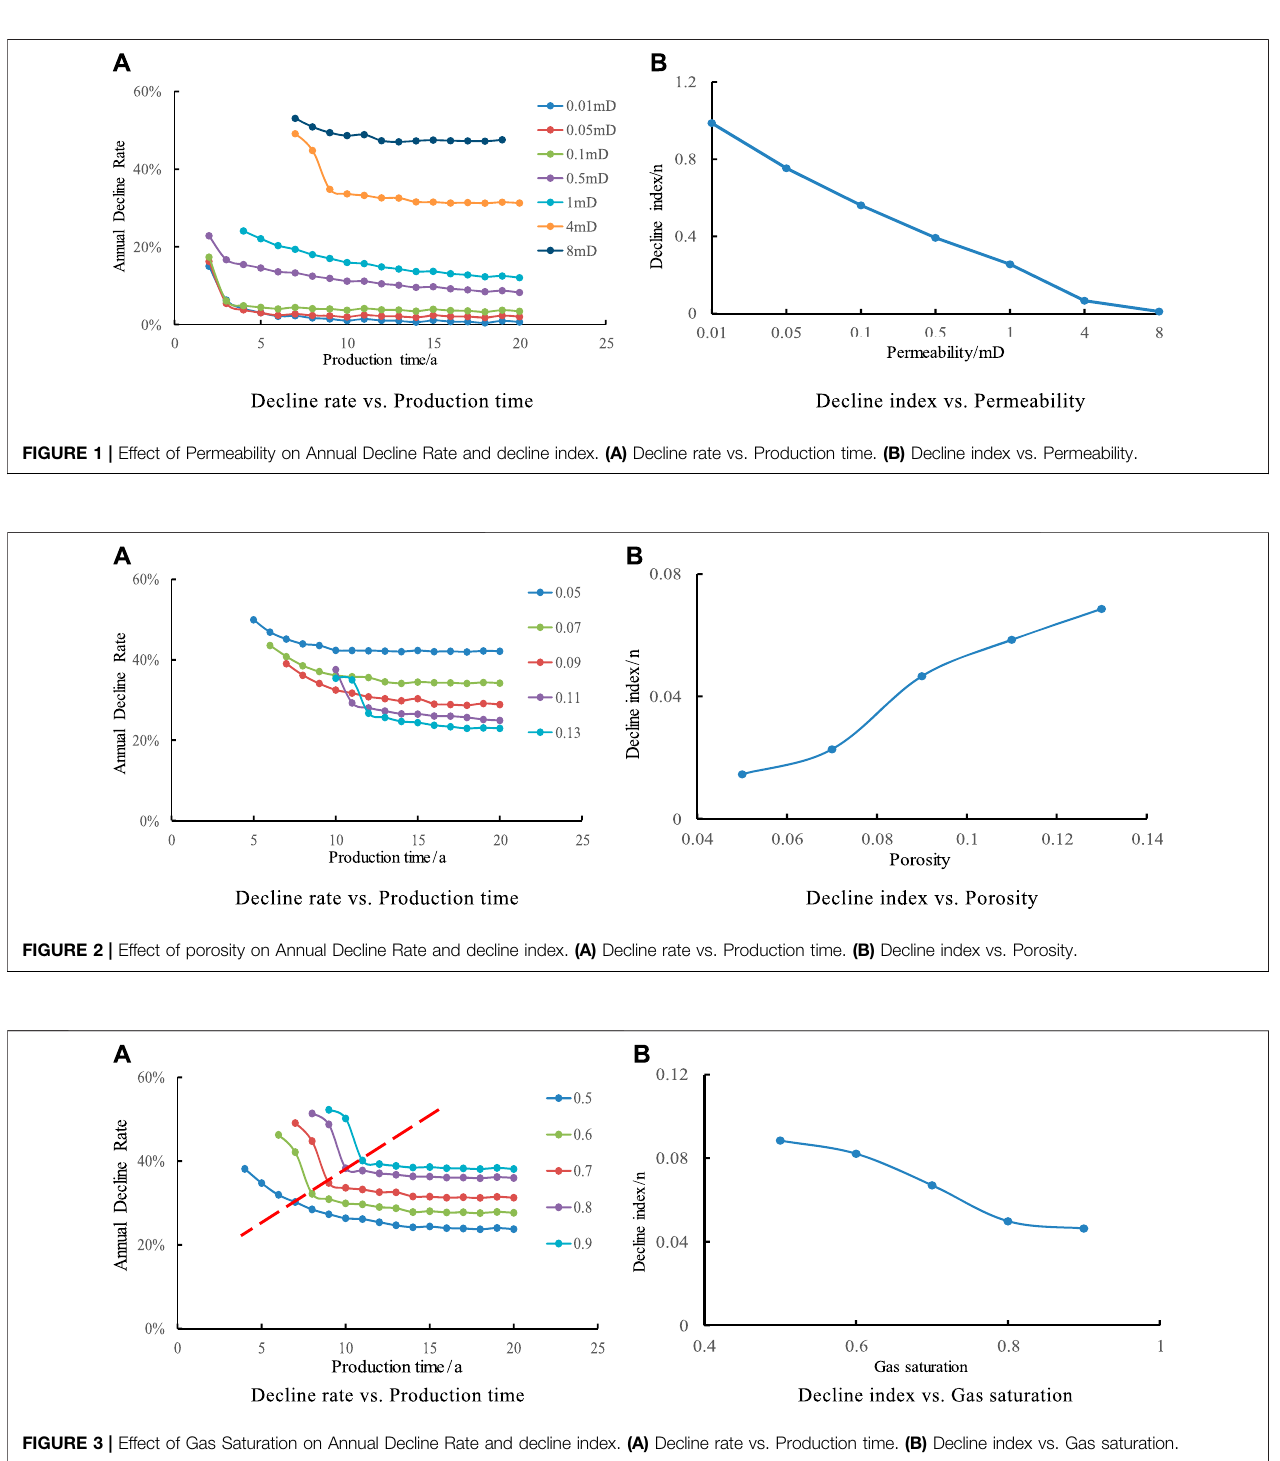
Frontiers in Physics |